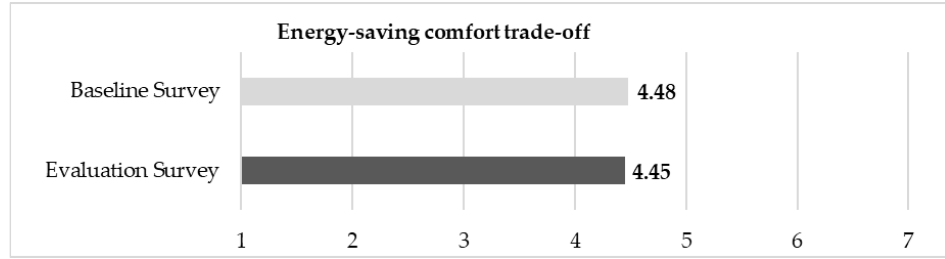
Figure 6. A comparison of energy-saving–comfort trade-off scores in Greek public buildings (before and after the trial).